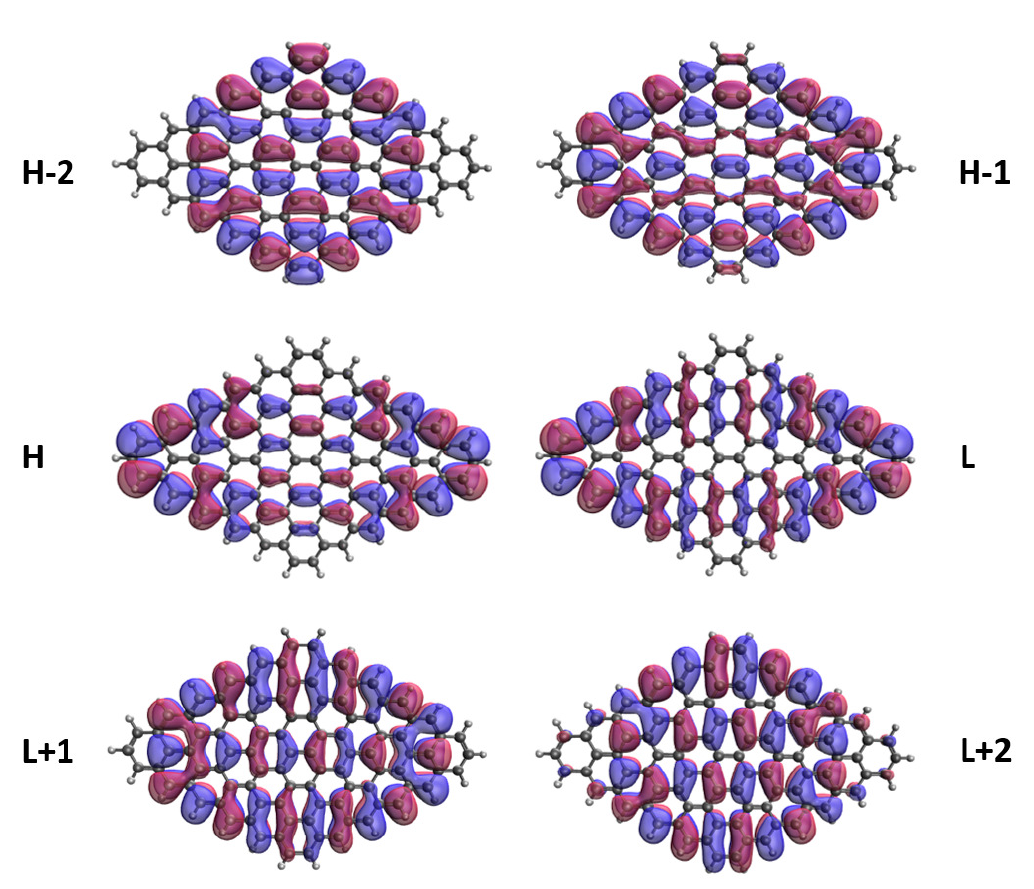
Figure 10. Real-space representation of H − 2 (1.905), H − 1 (1.524), H (1.161), L (0.852), L+1 (0.478), and L+2 (0.080) of ground-state 6-pyrene, calculated by spin-restricted TAO-LDA. Here the isovalue is 0.02 e/Å 3 . The occupation numbers of active orbitals are given in parentheses, and HOMO/LUMO is denoted as H/L for